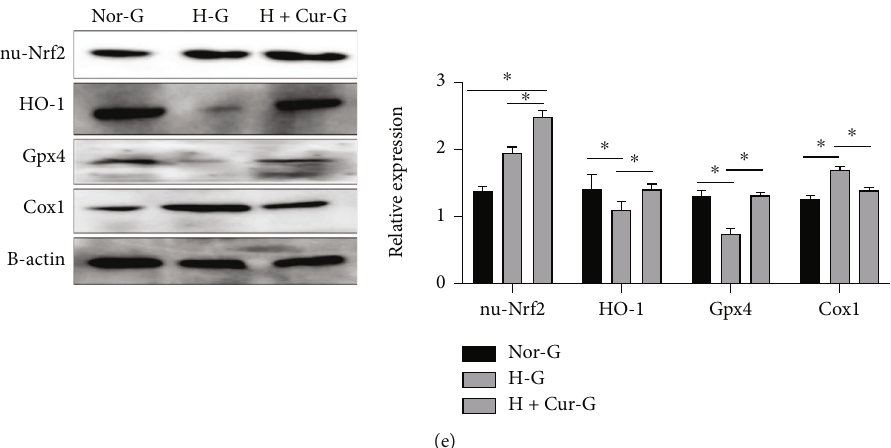
Figure 2: Curcumin improves myocardial cell damage. Nor-G: 5.5mmol/L glucose concentration; H-G: 30mmol/L glucose concentration; H-Cur-G: 30mmol/L glucose concentration +curcumin. (a) CCK-8 assay detected myocardial cell activity at di ff erent curcumin concentrations. (b) Expression level and localization of Nrf2 assessed by immuno fl uorescence ( × 200). Fluorescence colocalization analysis showed that curcumin induced Nrf2 nucleus localization with a Pearson correlation coe ffi cient of 0.59, indicating a strong correlation. (c) Apoptosis and intracellular ROS levels were measured using TUNEL and ROS fl uorescent probes ( × 200). (d) Gpx4 cell expression was detected using immuno fl uorescence ( × 200). (e) The expression levels of Nrf2 protein in the nucleus and ferroptosis pathway-related proteins were detected by western blot ( ∗ P < 0 : 05